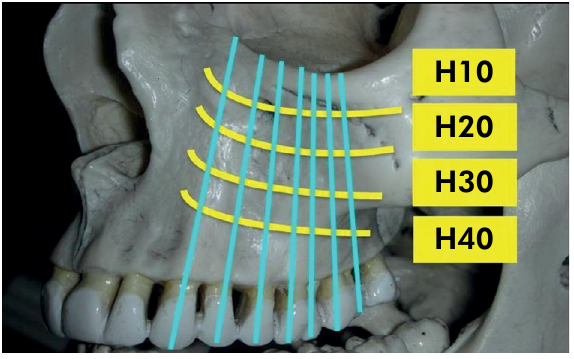
Figure 1. Illustration showing the points of measurement at the buccofacial wall of the maxillary